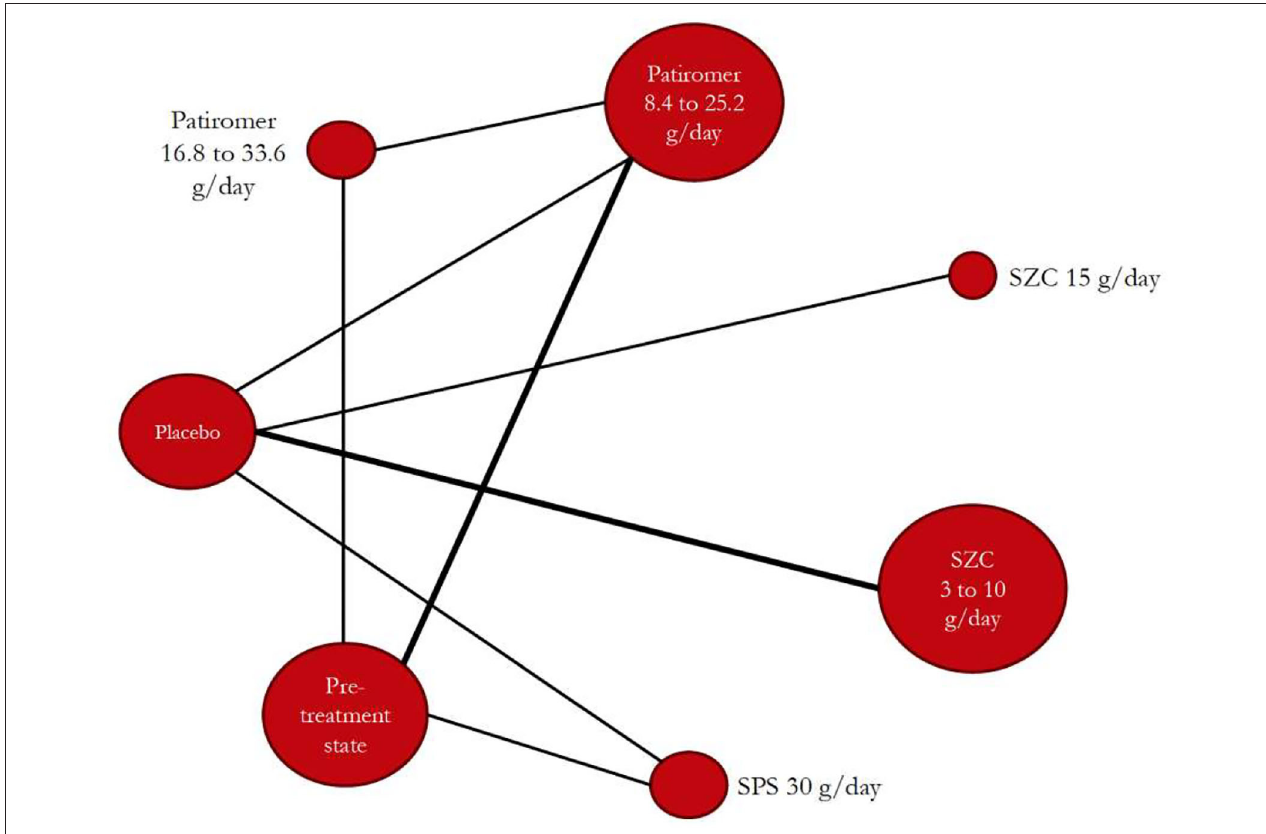
FIGURE 3 | Bayesian network diagram constructed with the retrieved trials after searches and considering all evaluated potassium-binding polymers (nodes) and with showing all comparisons (lines between nodes). SPS, sodium polystyrene sulfonate; SZC, sodium zirconium